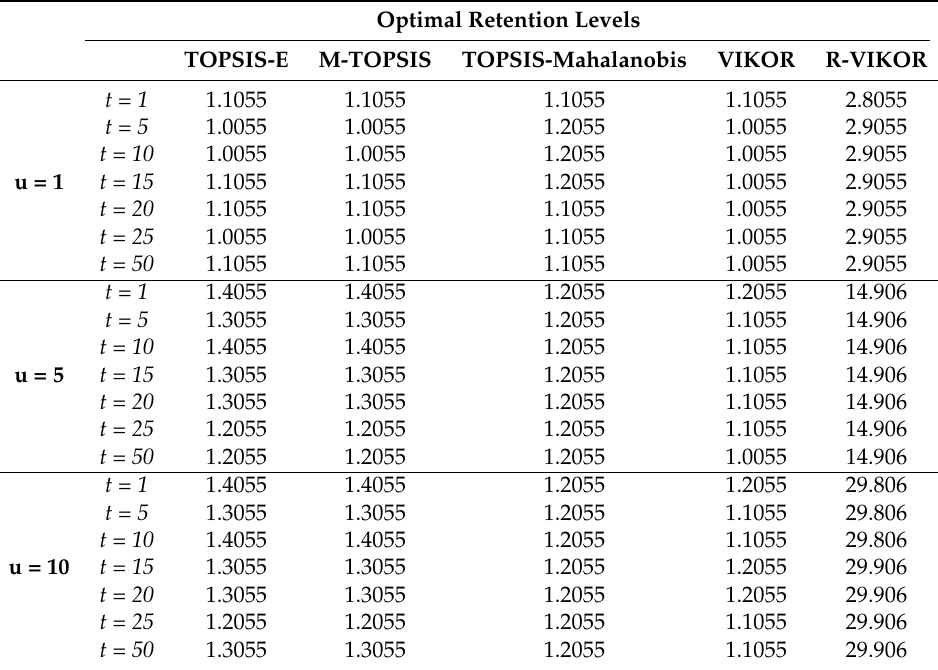
Table 3. Optimal retention level under the expected value premium principle.